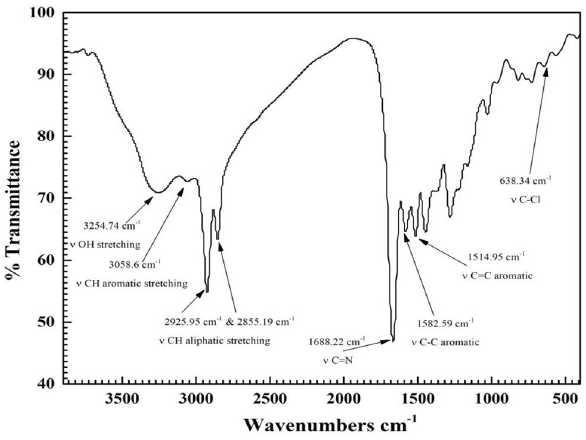
Figure 1. FTIR spectrum of CS4 compound.